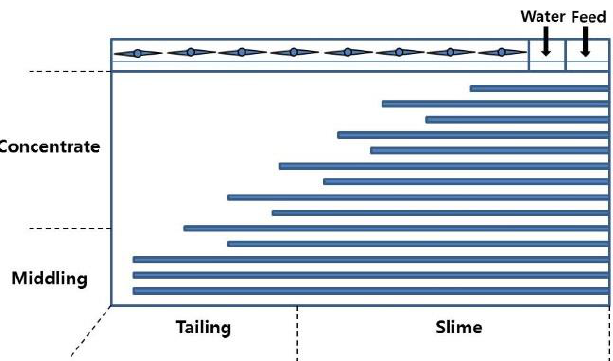
Figure 1. Categories of recovered samples in shaking table experiment.